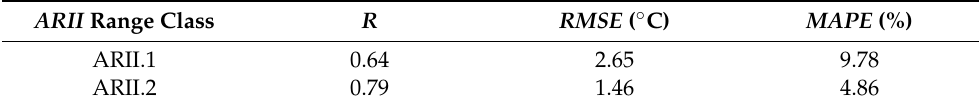
Table 11. Example 3.0.2. Statistical parameters for the courtyard measured temperature in each selected courtyard of each ARII range